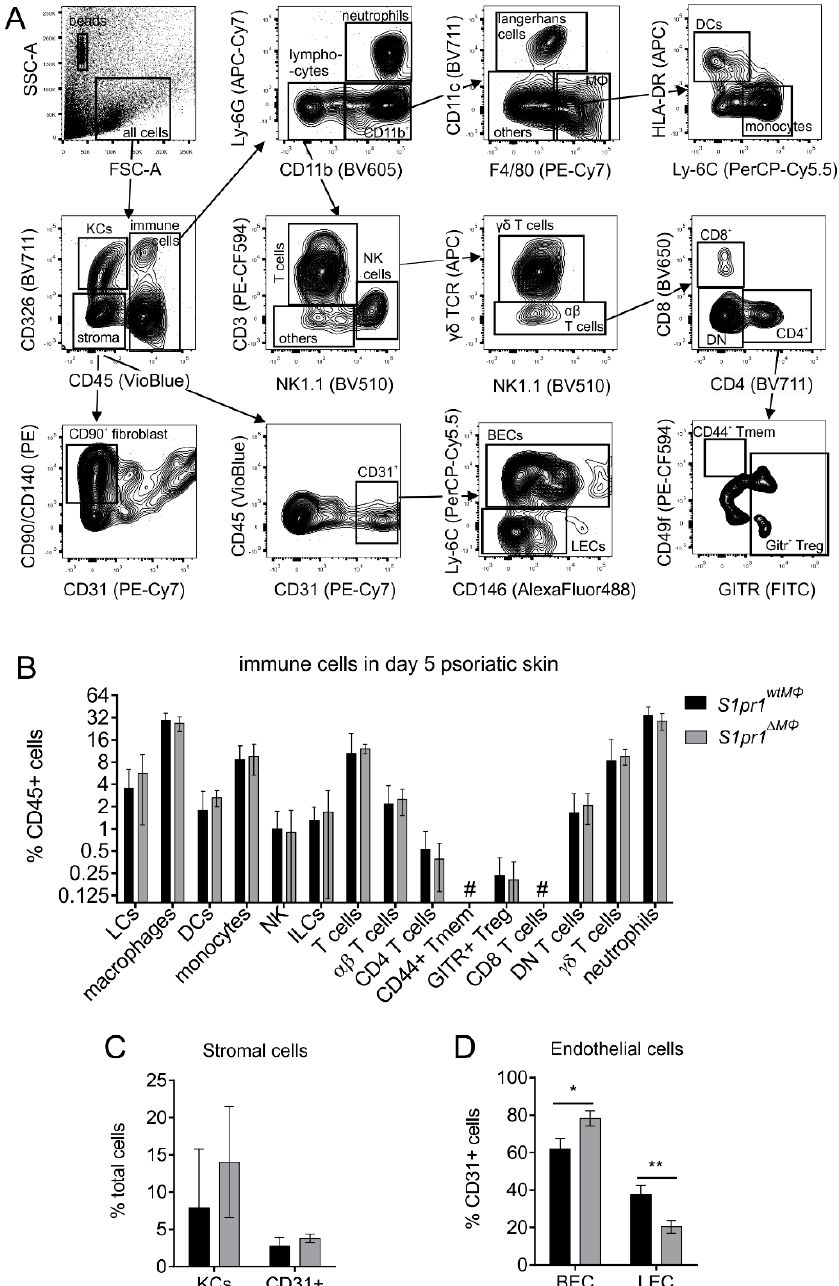
Figure 3. Psoriatic skin cell profile of S1pr1 wtM Φ and S1pr1 ∆ M Φ mice. Immune and endothelial cell subsets in psoriatic skin of S1pr1 wtM Φ (black bar) and S1pr1 ∆ M Φ (grey bar) mice at day 5. ( A ) Gating strategy. ( B ) Psoriatic back skin immune cells were separated based on their surface markers. ( C ) Keratinocytes were separated as CD45 - CD326 + . Blood and lymphatic endothelial cells were identified in CD45 - CD326 - fraction, which were further separated by ( D ) CD31 + CD146 + Ly-6C +/ - . Data are means ± SD, n = 4 individual animals. * p < 0.05; ** p < 0.001; p values were calculated using two-tailed multiple t -test with Holm–Šídák correction (C-G). #, below % detection.